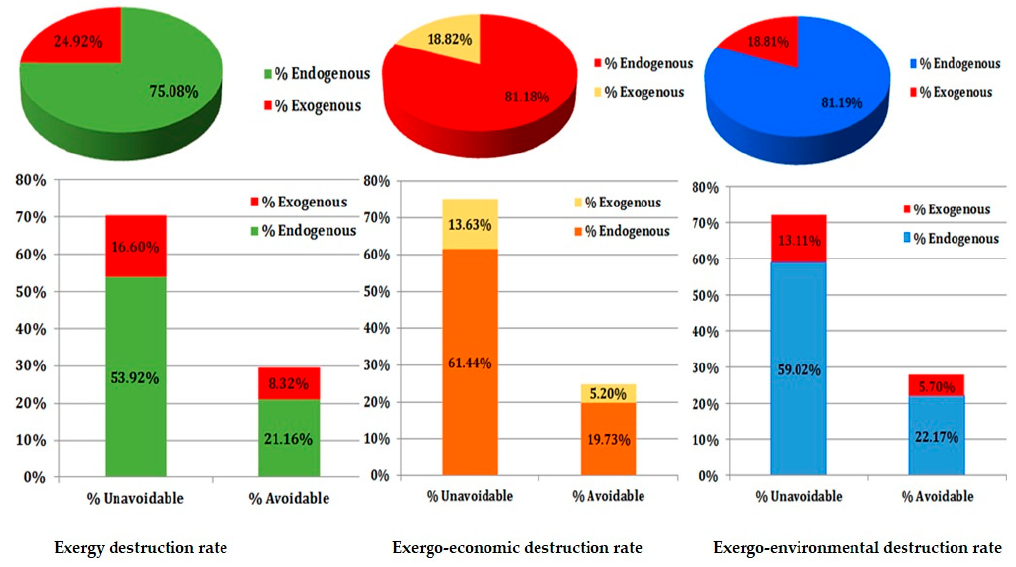
Figure 10. Advanced exergy destruction rate of the solar–geothermal cycle